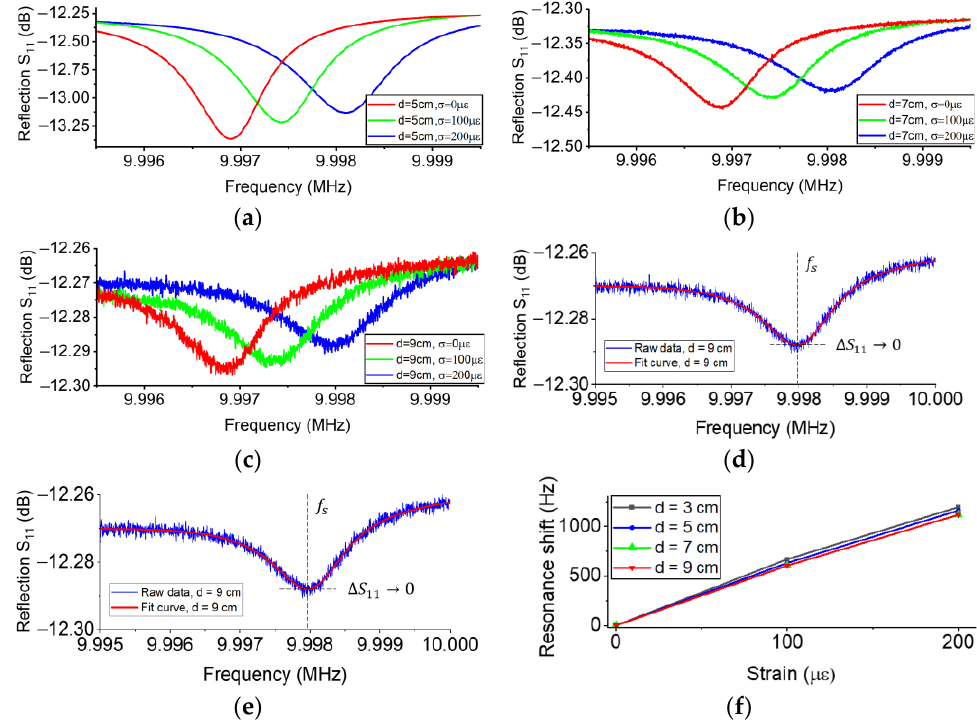
Figure 10. The effect of the wireless sensing distance on the sensitivity of a BAW passive wireless strain sensor. Resistance compensation was not used. All signals are the original data. ( a – c ) The effect of payloads on the signal when the distance was 5 cm, 7 cm, and 9 cm, respectively. ( d , e ) The curve fitting of the signal when the distance was 5 cm and 9 cm, respectively. ( f ) The resonance shift as a function of strain when the distance was different.